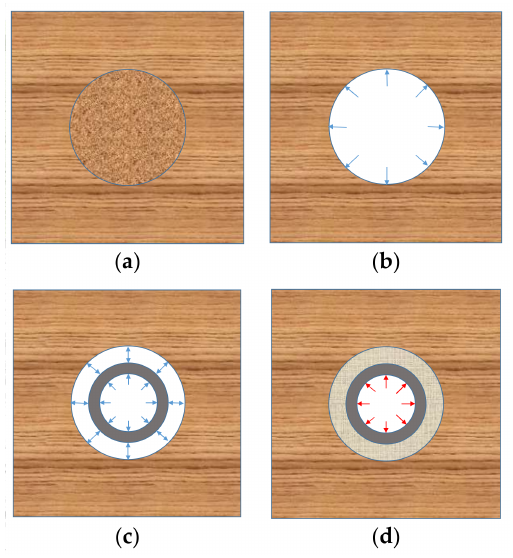
Figure 2. Sketch of the step by step method. ( a ) Initial state; ( b ) drilling; ( c ) cementing; ( d ) hydraulic fracturing.